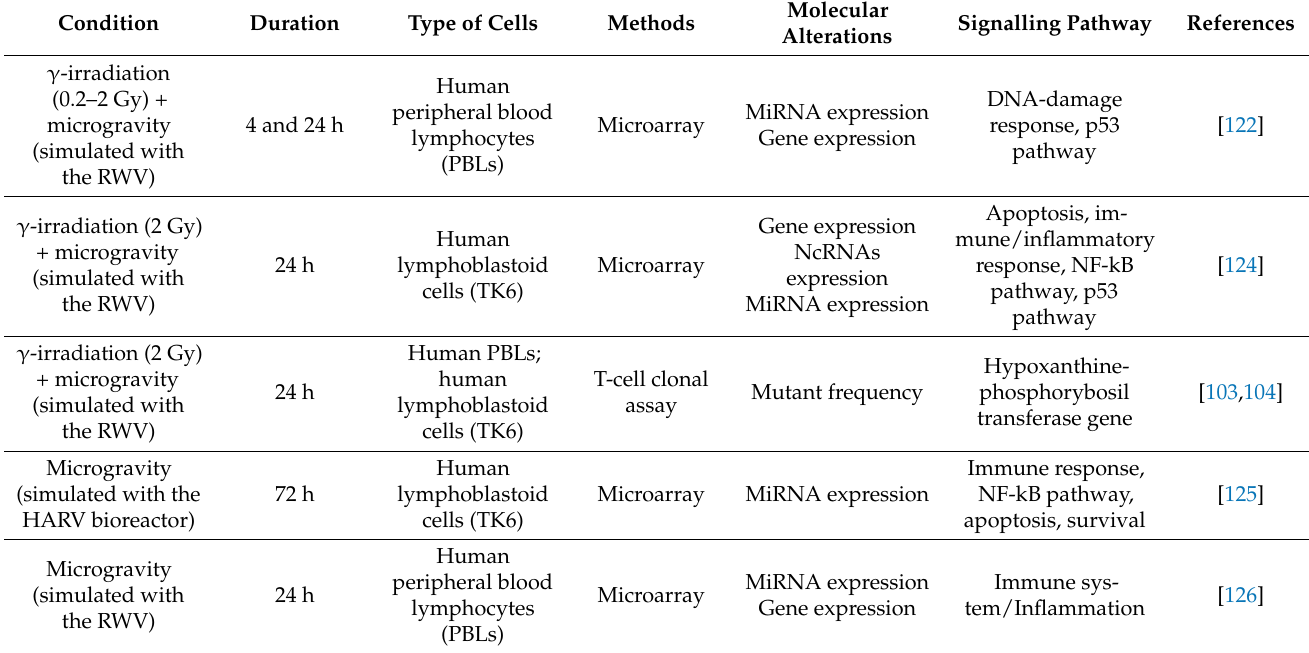
Table 2. Genomic alterations in human cells incubated in simulated space